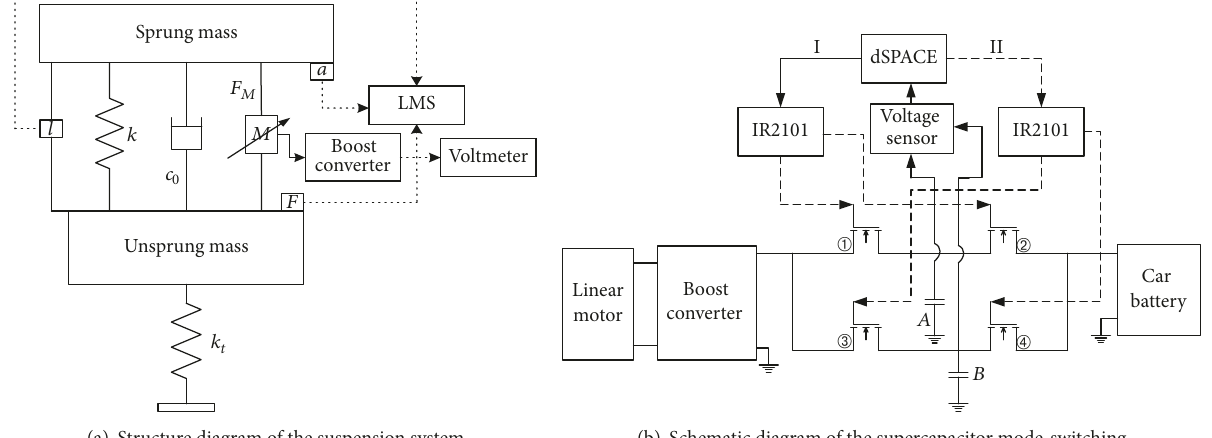
Figure 7: Experiment schematic